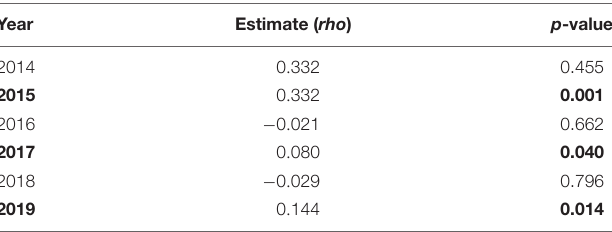
TABLE 4 | Results of Mantel tests for correlation between yearly simple ratio index (SRI) matrices and shark